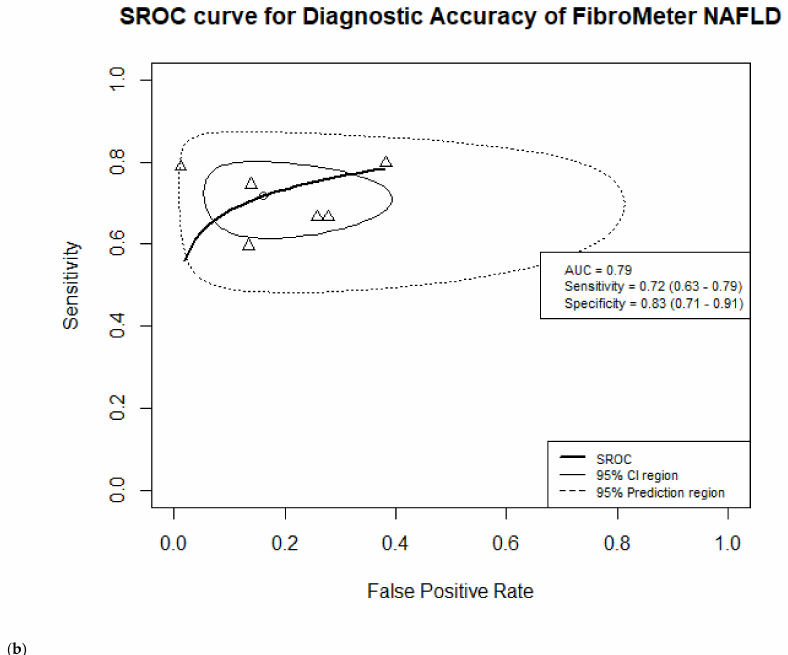
Figure 3. Summary receiver operating characteristic (SROC) curve of the diagnostic accuracy of FibroMeter NAFLD for target condition advanced fibrosis. The solid ellipse presents the 95% con- fidence interval region of diagnostic accuracy of FibroMeter NAFLD; the dotted ellipse presents the prediction region in which 95% of future diagnostic accuracy study estimates of FibroMeter NAFLD will fall. Triangles represent diagnostic accuracy estimates from each included study; circle presents the Youden Index threshold value. ( a ) Before additional sensitivity analyses; ( b ) After additional sensitivity analyses, without study of Loong et al.